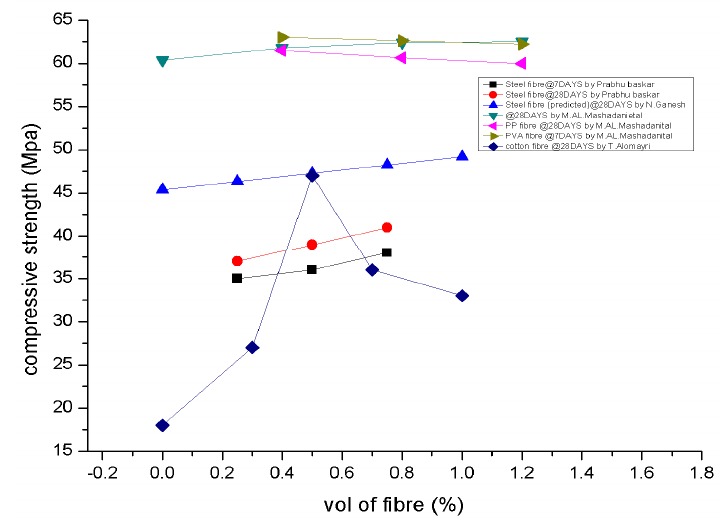
Figure 5. Compressive Strength